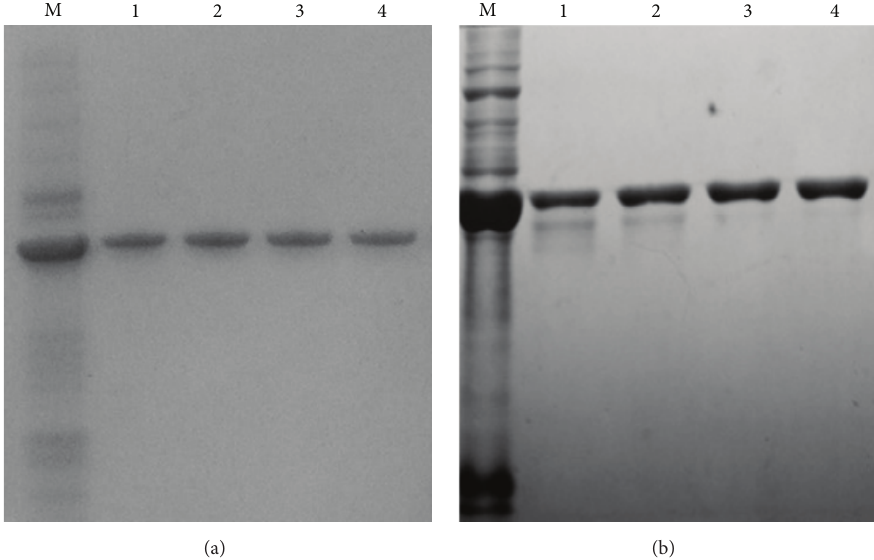
Figure 1: The fractions of rOmpH purified by electroelution were analyzed using SDS-PAGE (a) and probed with anti-HisG-HRP antibody (b). Lane M: cell lysates of the E. coli host. Lanes 1–4: rOmpH fractions purified using electroelution.